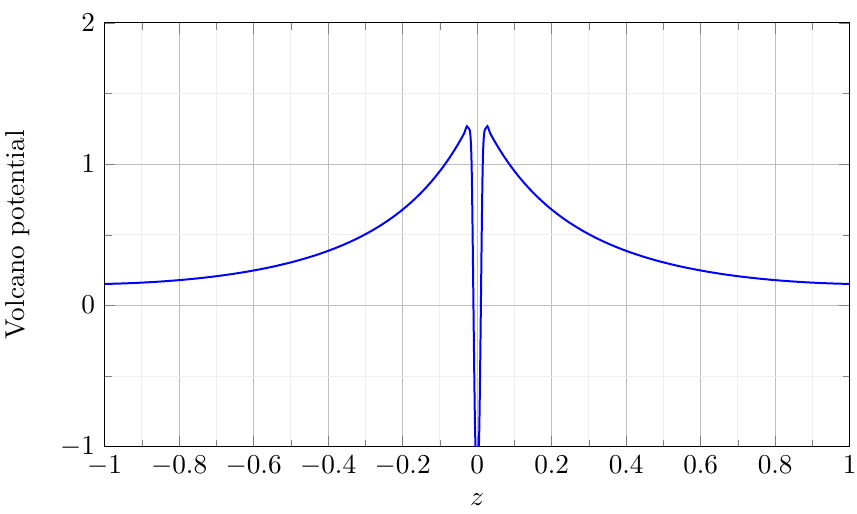
Figure 11 . The volcano potential. The positive tension brane locates at z = 0 and the reference brane locates at z = 1 . Note that there is a Z 2 symmetry at z = 0